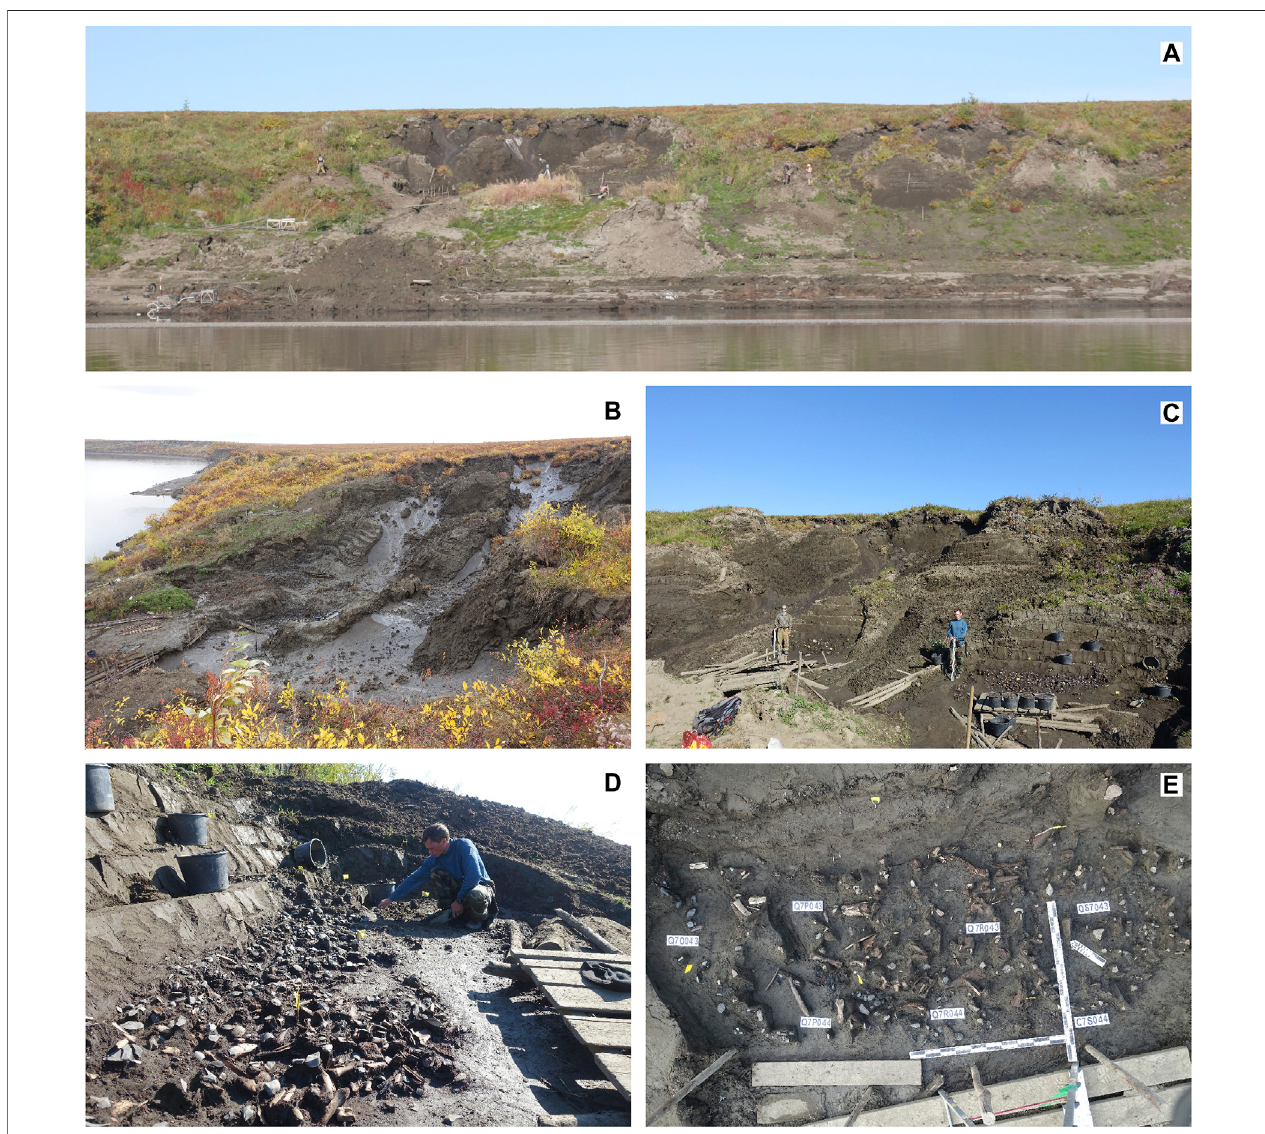
FIGURE 3 | The Yana B area of the Yana site complex: (A) left riverbank in the location of the Yana B area of the Yana complex of sites viewed in 2017; (B) excavations in the Ice Complex environment viewed from an Eastern elevation in 2019; (C) excavated areas of the cultural horizon in two polygons located nearby, in 2019; (D) excavation process on one of such polygons performed in 2018; (E) ancient habitation surface displaying numerous fi nds of lithic artifacts and Pleistocene animal bones and their fragments.